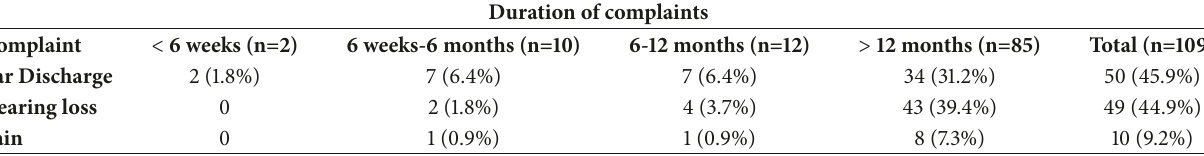
Table 2: Patients’ complaints compared to duration from onset to care seeking.